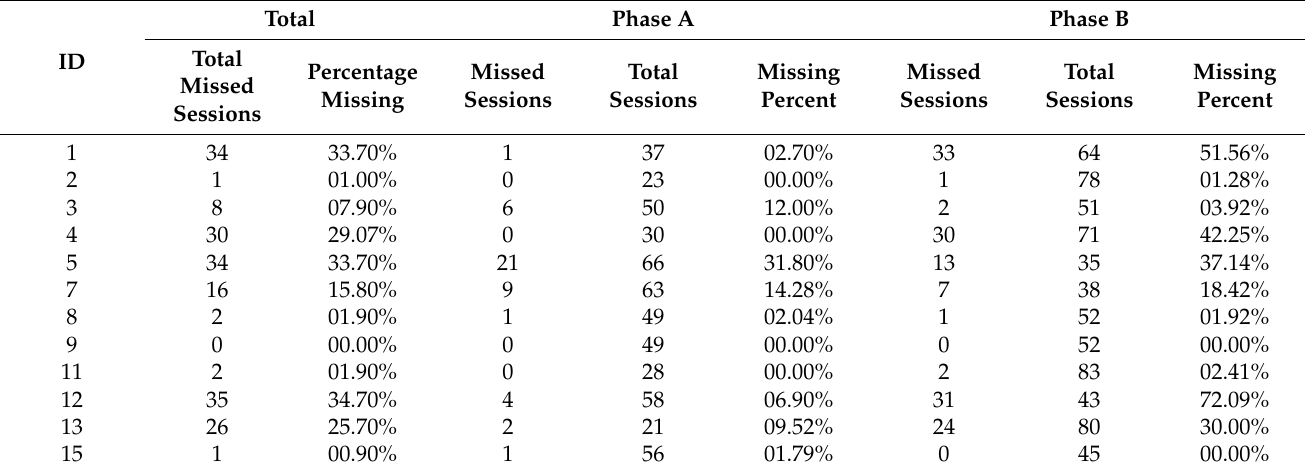
Table 8. Missing data per participant on daily measures of stress and PF.